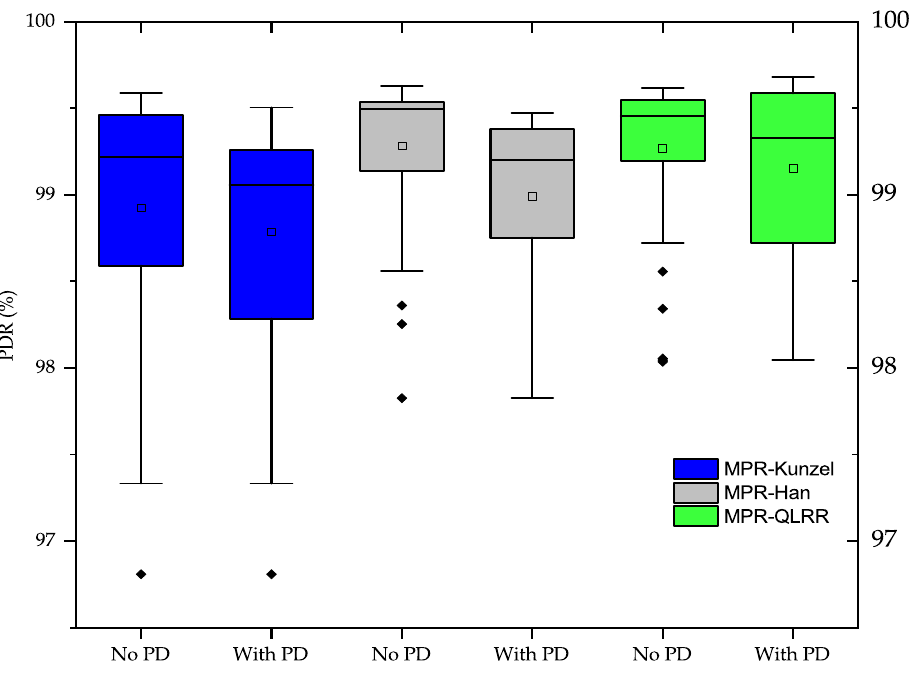
Figure 12. Packet delivery ratio (PDR) with and without packet